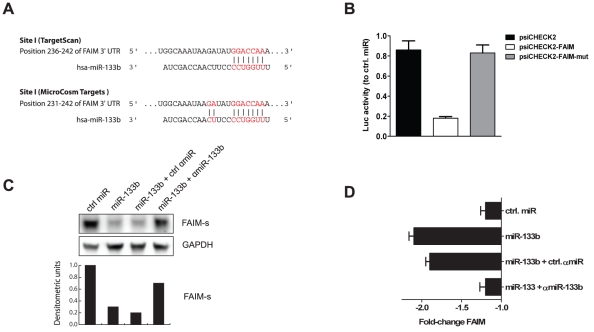
Fas apoptosis inhibitory molecule (FAIM) expression is regulated by miR-133b.(A) miR-133b target sites within the 3′-UTR of FAIM as predicted by TargetScan and MicroCosm Targets. (B) 3′-UTR targeting assay. HeLa cells were cotransfected with different combinations of miR mimics and a luciferase reporter plasmid harboring the complete 3′-UTR of FAIM (psiCHECK2-FAIM) or the mutated version thereof (psiCHECK2-FAIM-mut). Template plasmid (psiCHECK2) was used as a negative and normalization control. Activity of the 3′-UTR-dependent luciferase (Renilla reniformis) was measured 48 h post-transfection and normalized for transfection efficiency to the one produced by the miR- and 3′-UTR-independent luciferase (Photinus pyralis). Error bars indicate standard deviation. (C) Western blot and densitometric analysis of FAIM expression. Cells were transfected with miR-133b alone or together with ctrl αmiR or specific αmiR-133b. After 48 h, cellular protein lysates were prepared and FAIM expression was assessed by Western blot. GAPDH was used as an internal loading standard. Ctrl miR-transfected cells were used as a reference for densitometric quantification of protein band intensity. (D) qPCR analysis. Cells were transfected for 48 h before total RNA was isolated, reverse transcribed and analyzed by qPCR for expression of FAIM. Human acidic ribosomal protein (HuPO) was used as the housekeeping gene for internal normalization. Fold-change (FCH) values are shown relative to mock-transfected cells incubated under the same conditions. All graphs are representative of at least three independent experiments.